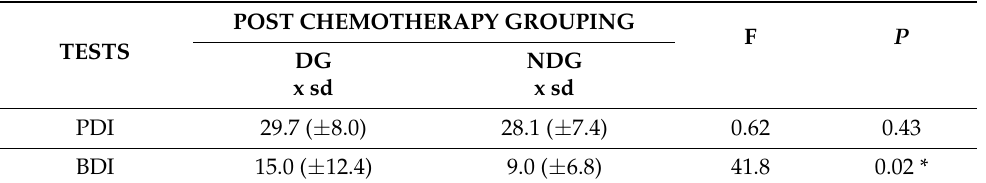
Figure 4. Descriptive Plot for BDI scoring in Post Chemotherapy evaluation